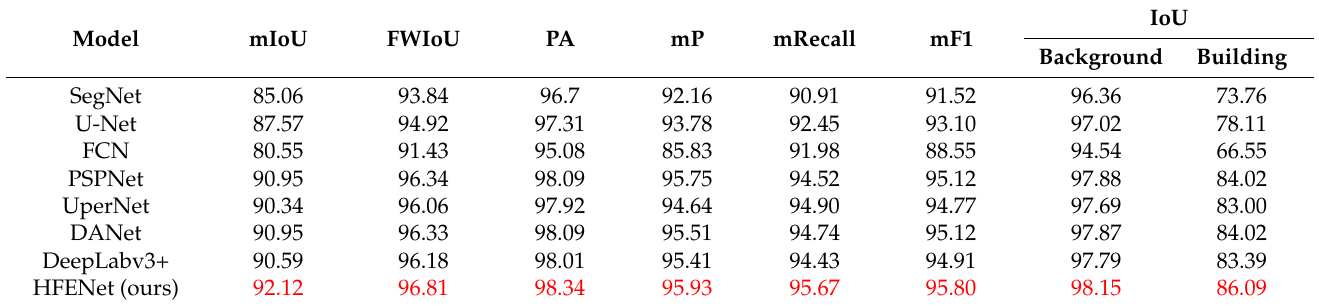
Table 6. Quantitative results of the state-of-the-art models on the WHU building dataset (%).